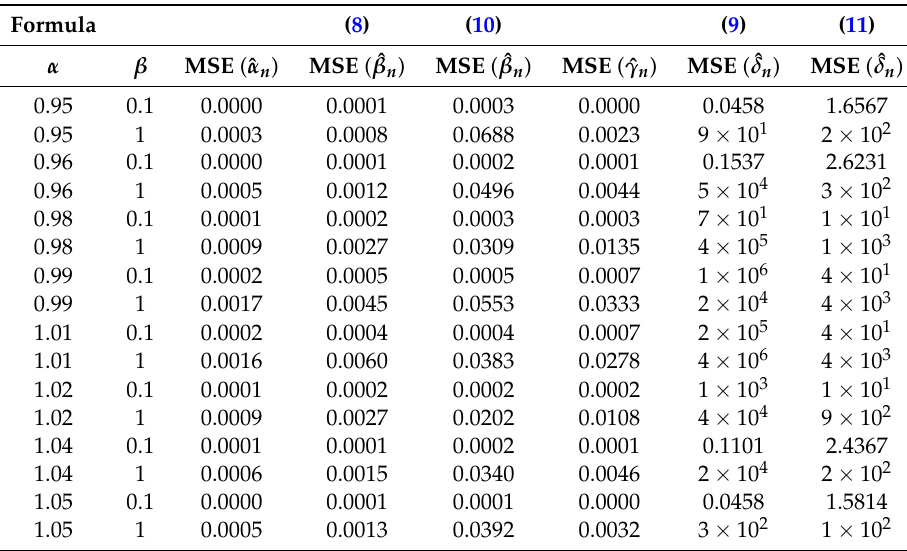
Table 2. MSEs of cumulant estimates for S ( α , β ,1,0;1 ) , n = 10 − 5